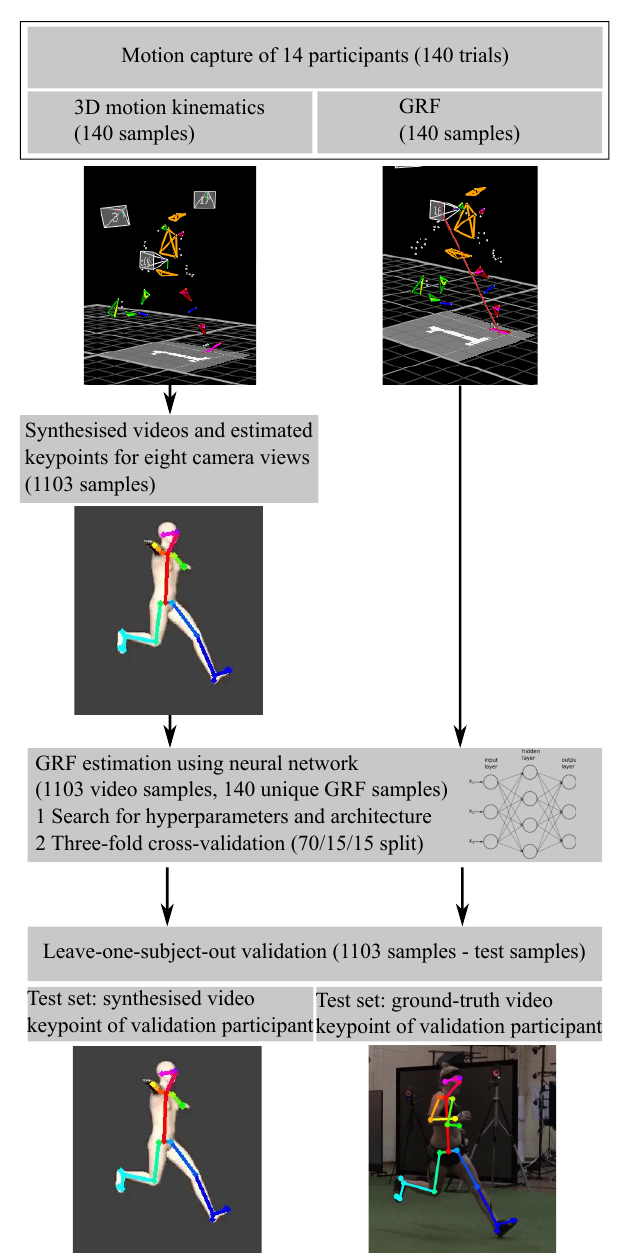
Figure 7. Design overview of the machine learning application to estimate ground reaction forces using synthesised 2D video